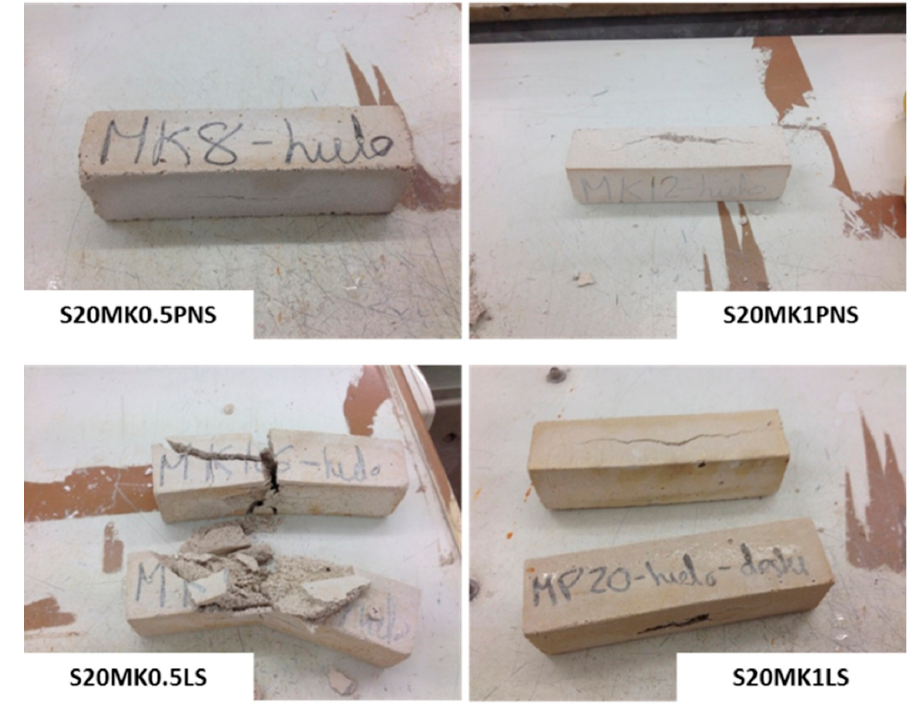
Figure 12. Appearance of different grouts after 10 freeze-thaw cycles. Table 5. Visual alteration after 5, 10, 15, and 20 freezing-thawing (FT) cycles showing numerical values of the damage scale *.